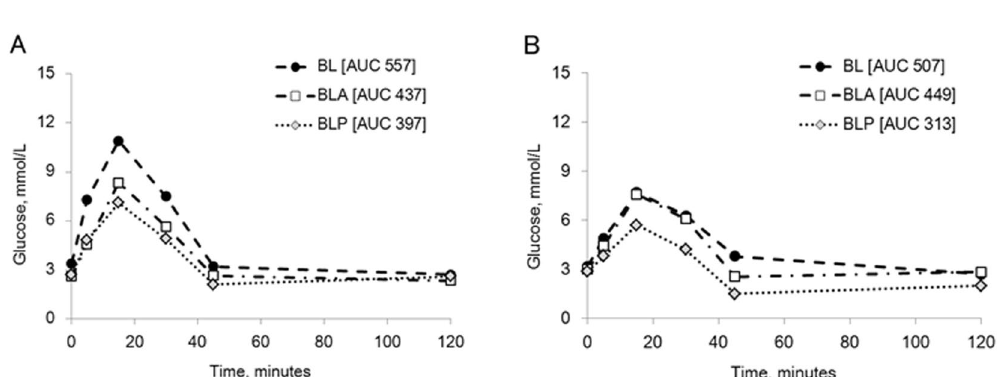
Figure 8. ( A , B ) Blood glucose concentrations in parallel blood samples taken from the portal (visceral) vein ( A ) and jugular (peripheral) vein ( B ) during the GTT from one of DJB pigs presented in Fig.